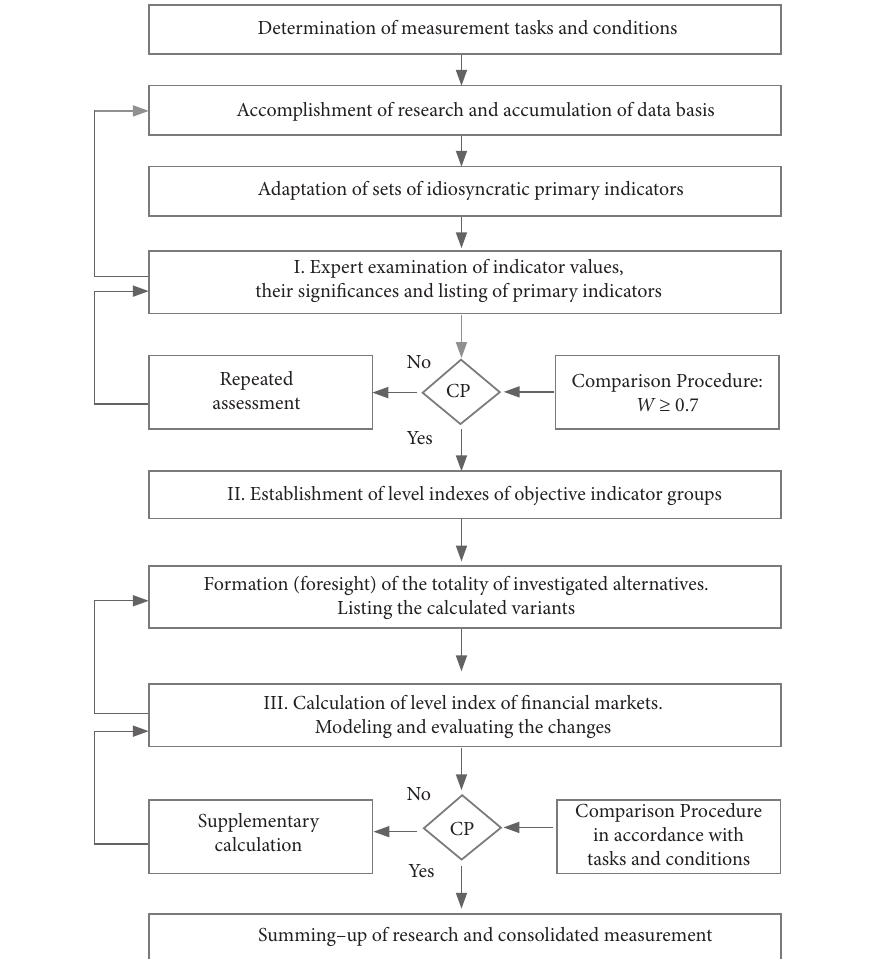
4. The basic models for the multicriteria assessment of financial markets development The basic models for consolidated quantitative measurement of separate indicator groups (including models evaluating the group of market sophistication indicators, the group of securities exchange indicators, the group of banking sector indicators, and the group of insurance sector indicators) as well as for the measurement of a country’s financial markets development level were developed on the basis of previous principal provisions. The